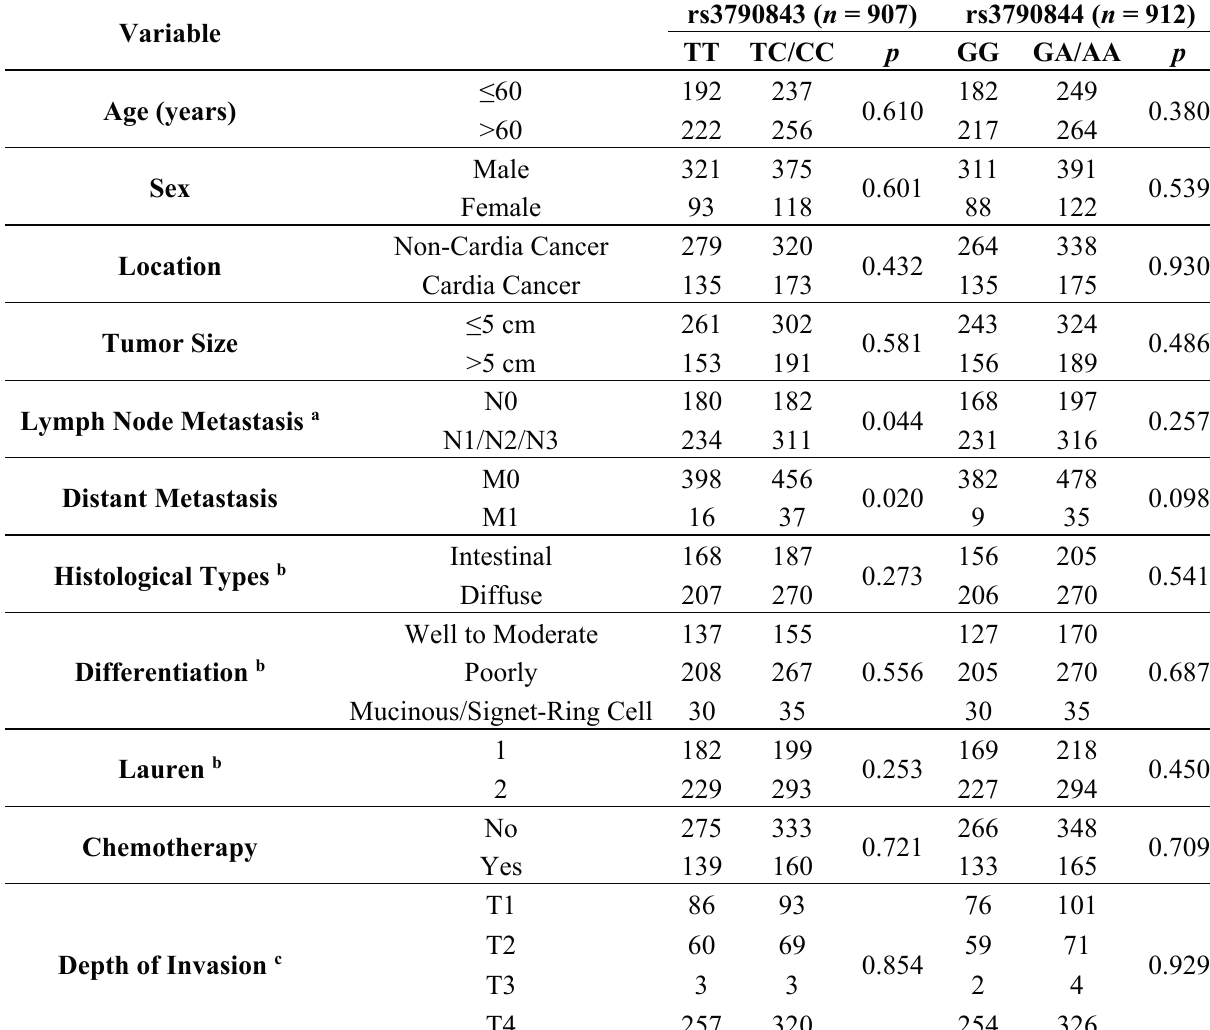
Table 2. Association analyses of NR5A2 rs3790843 and rs3790844 genotypes with clinicopathological